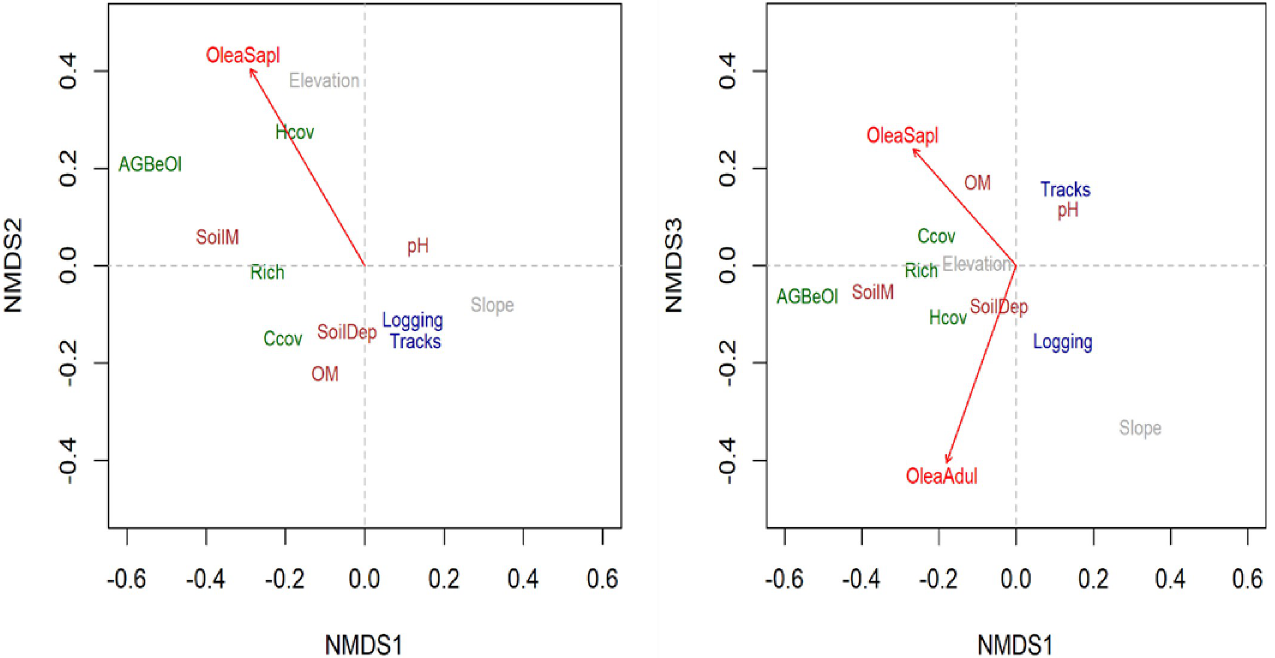
Fig 3. Nonmetric multidimensional scaling (NMDS) ordination of O . europaea life stages versus environmental conditions and human disturbance factors in Hugumburda dry Afromontane forest in northern Ethiopia. O . europaea .Life stages are shown in red, topographic factors are shown in dark grey, soil factors in brown, biotic factors in dark green and disturbancefactors in dark blue. O . europaea adult (OleaAdul), O . europaea sapling (OleaSapl), organic matter (OM), canopy cover (Ccov), richness (Rich), track length (Tracks), elevation (Elevation), slope (Slope), number of O . europaea stumps (Logging), herbaceous cover (Hcov), aboveground biomass of all trees except O . europaea (AGBeOl), soil moisture (SoilM), soil depth (SoilDep) and human footpaths